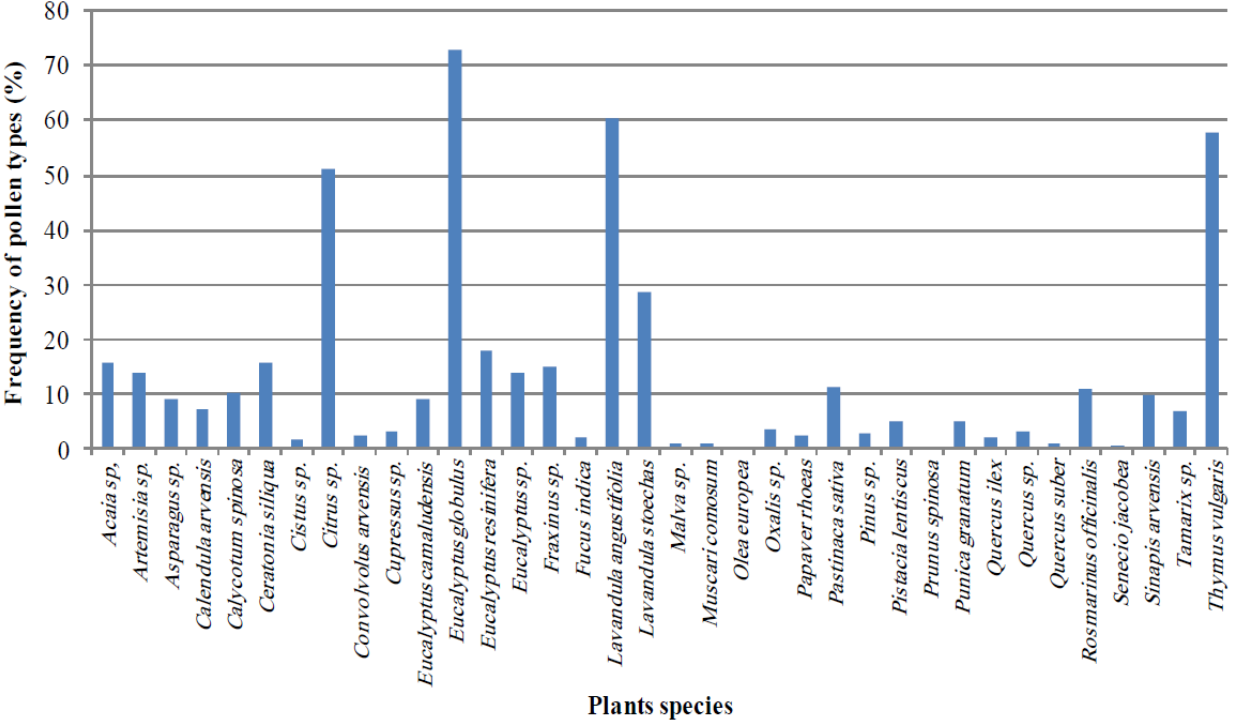
Figure 1. Somatorium of the pollen frequency of the identified plant species in ten samples of Algerian